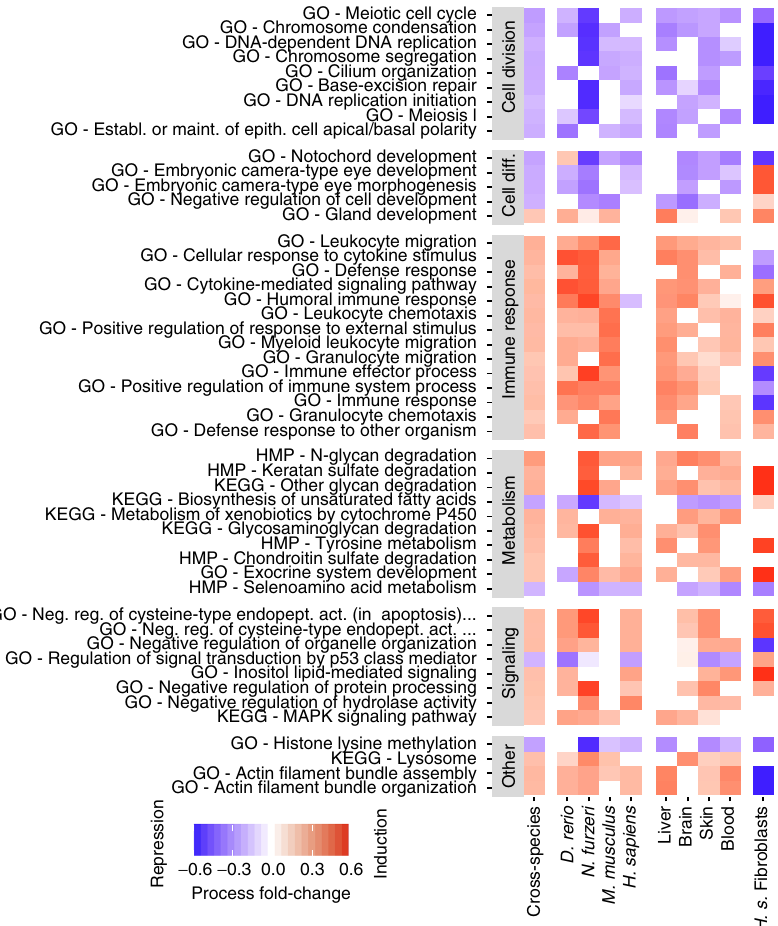
Fig. 2 Ageing-associated transcriptional changes across species and tissues. The top 50 differentially expressed processes between young and old individuals in the cross-species comparison are shown across all three ontologies (indicated in front of the labels). The fi rst column displays the main processes altered across all samples followed by columns presenting the results for individual species and tissues across species (only signi fi cantly ageing- regulated processes are displayed). Processes are grouped into functional categories and ordered in each category separately according to the p- value of ageing (see Methods). Abbreviations: HMP human metabolic pathways, H . s . Homo sapien s, GO gene ontology, KEGG Kyoto Encyclopedia of Genes